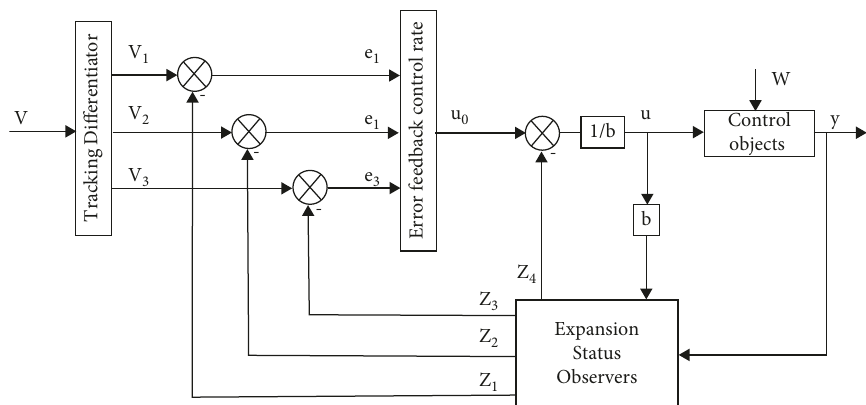
Figure 10: Control block diagram of the third-order self-tampering controller.